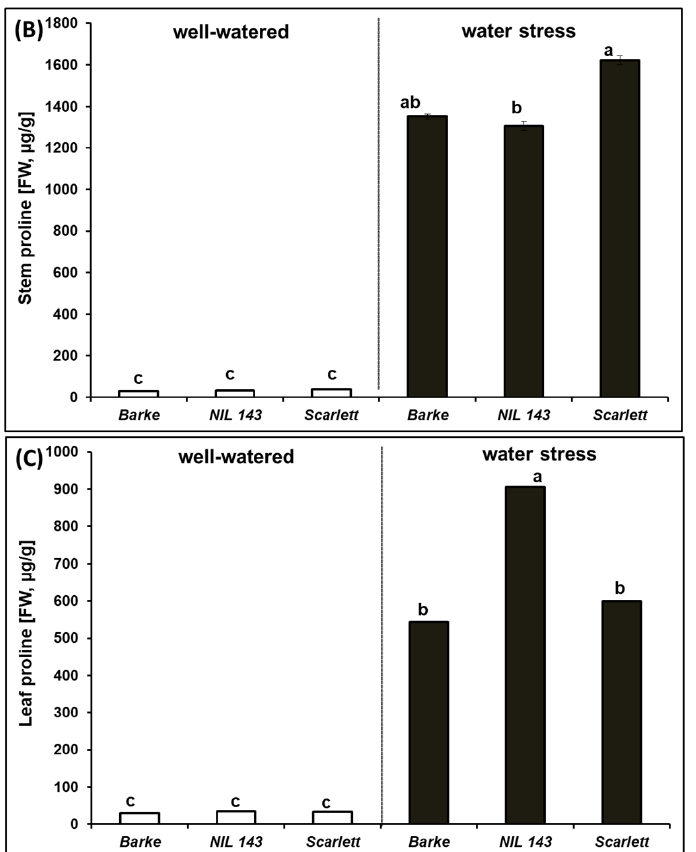
Figure 1. Proline concentration in the root—( A ); stem—( B ); and leaf—( C ) of the barley seedlings 17 days after water stress in rhizoboxes. Significant differences between the genotypes are based on Tukey’s post hoc test ( α = 0.05) indicated with different letters (n = 6).